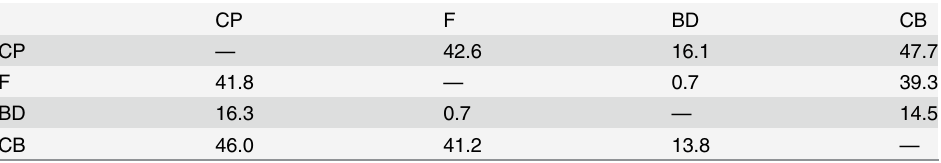
Table 2. Percent by area of co-benefits when priority areas are managed for an ES.